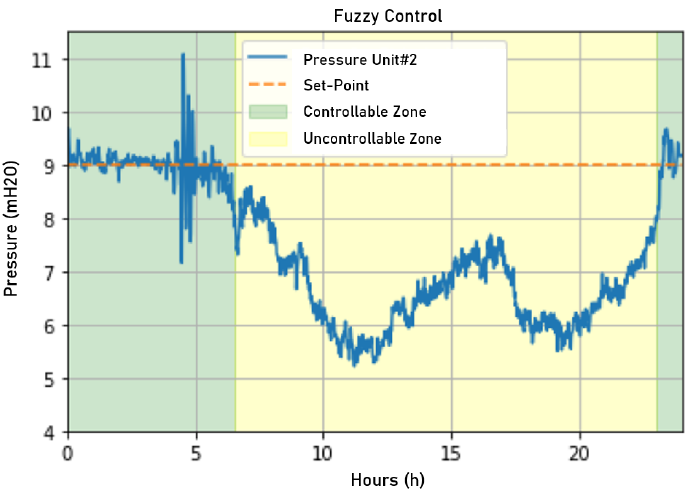
Figure 30. Pressure measured on the second day when applying fuzzy control. Source: author. The overvaluation registered after 8:00 p.m. was 7.5%. The instability registered for